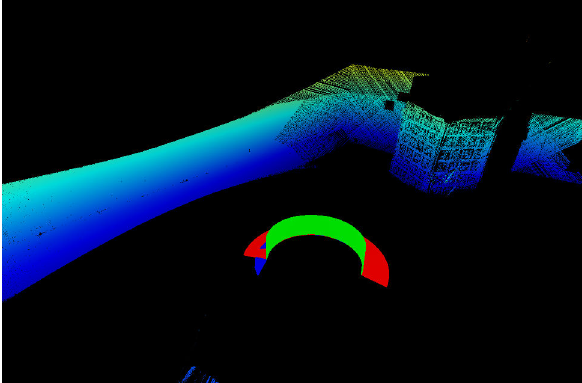
Figure 8. A point cloud of the L-shaped calibration pattern ac- quired with the 3D laser line